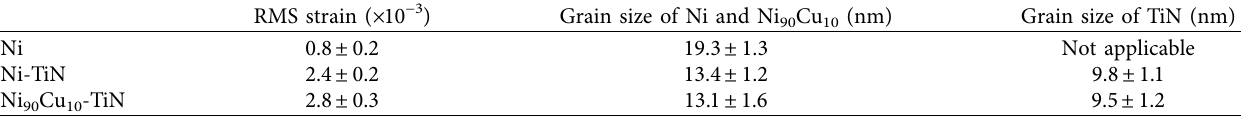
Table 2: Crystallite size and RMS strain obtained for Ni, Ni-TiN, and Ni